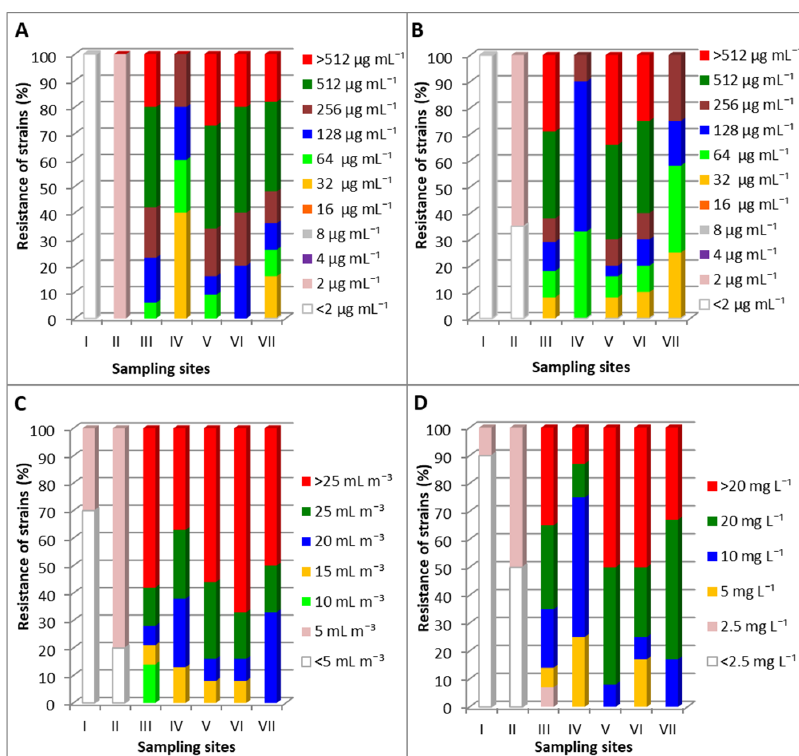
Figure 2. Minimum inhibitory concentrations (MIC) of: ( A )—cefotaxime ( µ g · mL − 1 ); ( B )—norfloxacin ( µ g · mL − 1 ); ( C )—Steridial (mL · m − 3 ) and ( D )—chloramine T (mg · L − 1 ) for opportunistic pathogens Pseudomonas fluorescens ( N = 63) isolated from the Drw˛eca